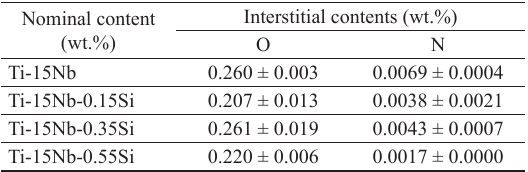
Table 1. Interstitial contents of furnace-cooled Ti-15Nb-xSi samples. Nominal content